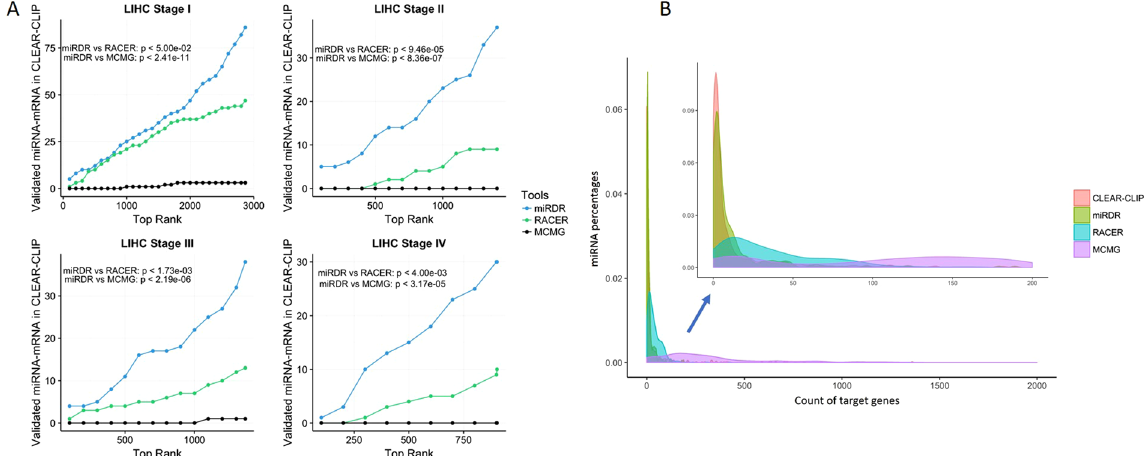
Figure 8. ( A ) Method comparison on the identified miRNA-target interactions on the test set. MiRDR, RACER and MCMG were applied on the Hepatocellular carcinoma (LIHC) data. The x-axis represents the top ranked interaction predicted by miRDR while the y-axis represents the count of validated interactions. The p-values were calculated by one-sided Wilcoxon singed rank test; ( B ) Method comparison based on the counts of identified miRNA targets. X-axis: number of target genes; y-axis: miRNA percentage. Outer plot shows the overall distribution and the inner shows the zoom-in view of partial distribution in the range of [0, 200].